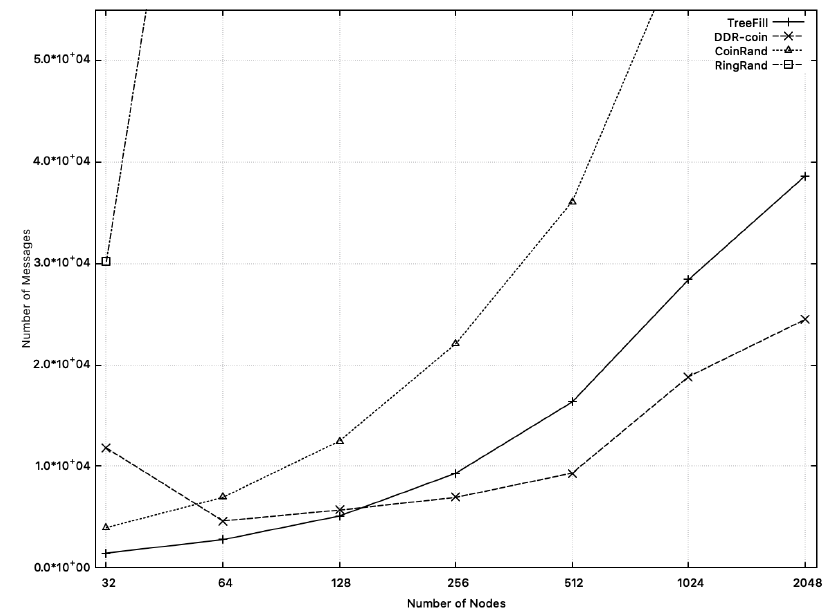
Figure 14. Comparison of the numbers of messages of DDR-coin, TreeFill, CoinRand, and RingRand when the number of nodes are 2 i where 5 ≤ i ≤ 10. The number of triggers is w =